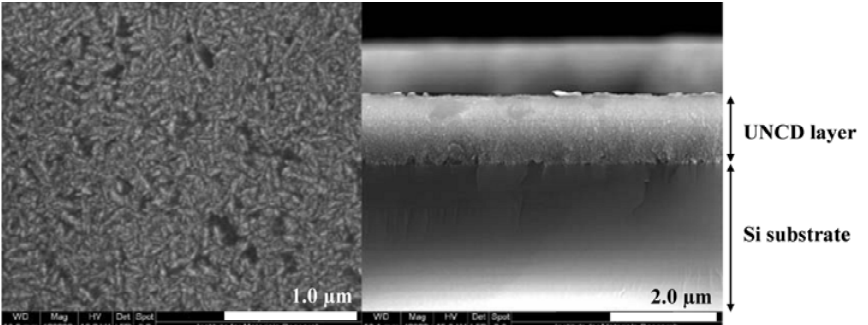
Figure 5. SEM images of a UNCD film on Si. In a topographical view, the even smaller grains on the surface are clearly visible (left panel). The cross-section is shown in the right panel (Institute for Materials Research, Belgium)